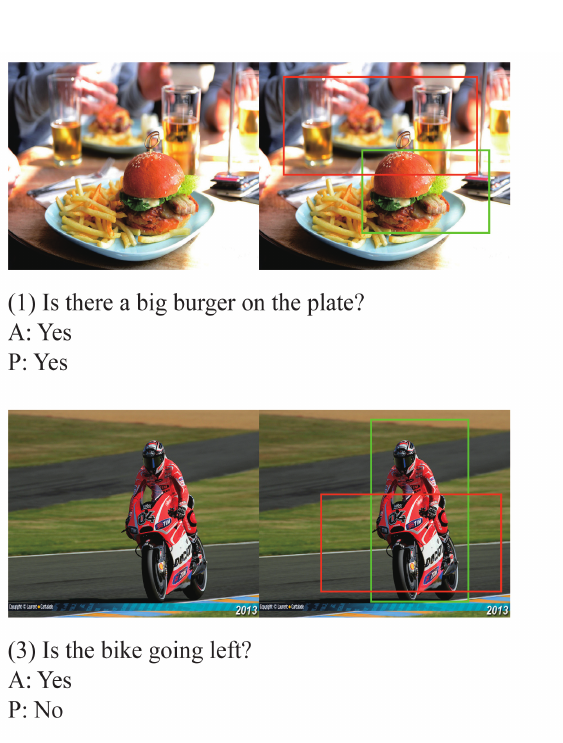
Figure 6. Several examples of the reasoning results of our VQA model. Different colors of the bounding boxes denote the different objects